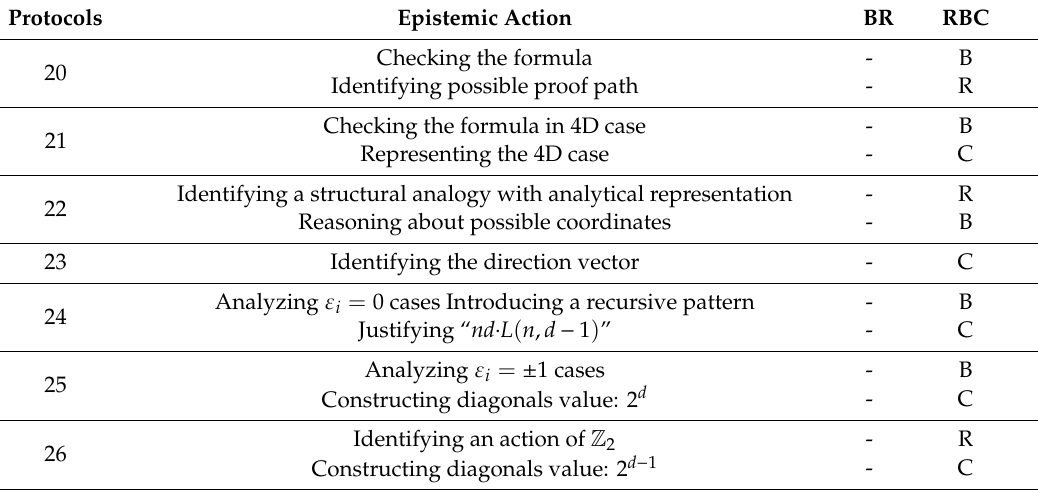
Table 5. Second excerpt of Student-A protocol: analysis of epistemic actions.